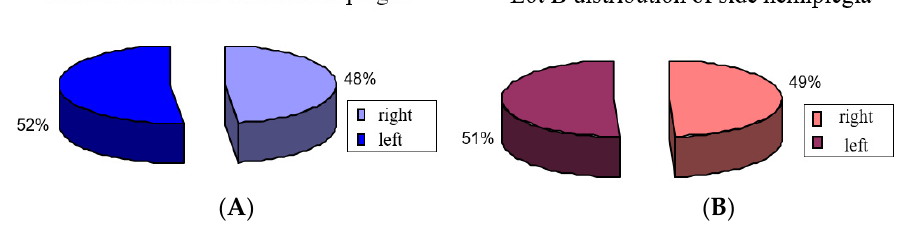
Figure 1. Distribution of side hemiplegia: ( A ) group A, ( B ) group B.